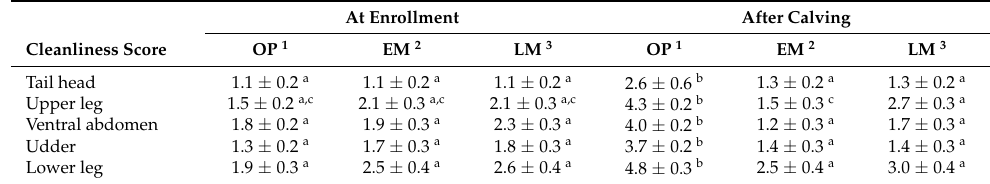
Table 4. Effect of housing treatment on cow cleanliness scores (LSM and SE) at enrollment of the study (3 weeks before to calving) and after calving (day 0) ( n : 13 per